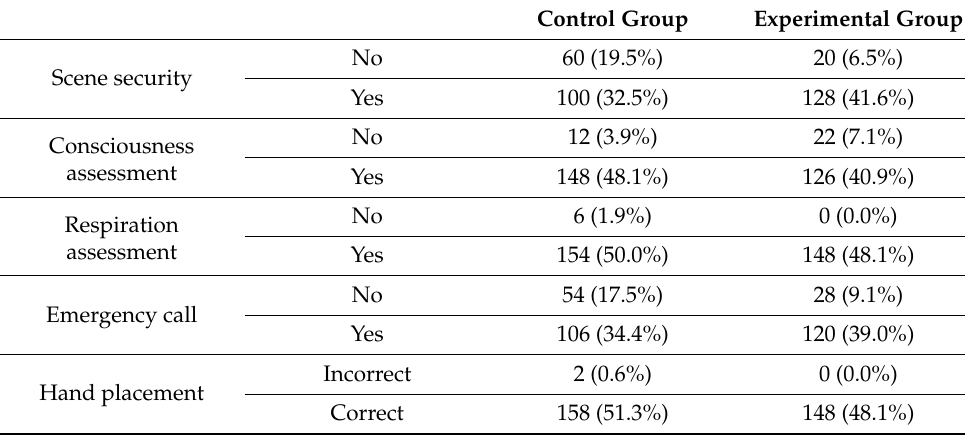
Table 2. Results for the descriptive analysis of the variables